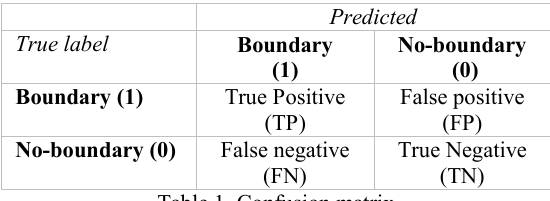
Table 1. Confusion matrix